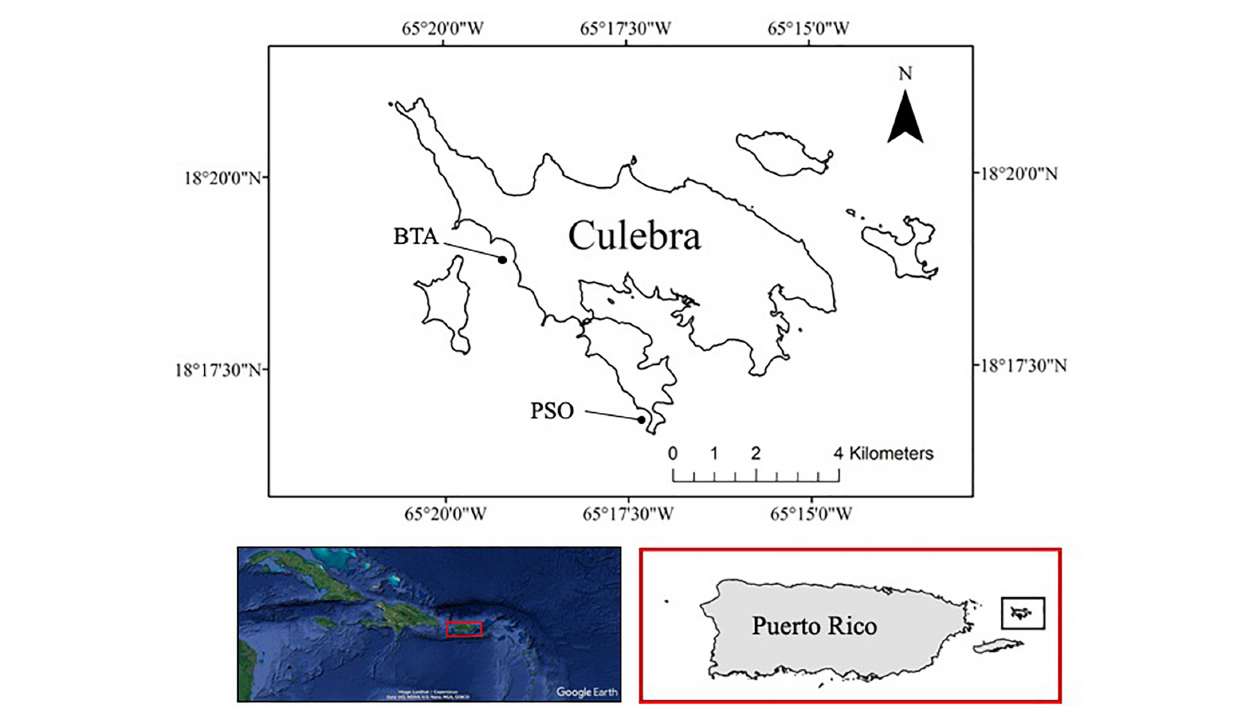
FIGURE 1 | Study site at Culebra Island, Puerto Rico. Bahía Tamarindo (BTA) and Punta Soldado (PSO).